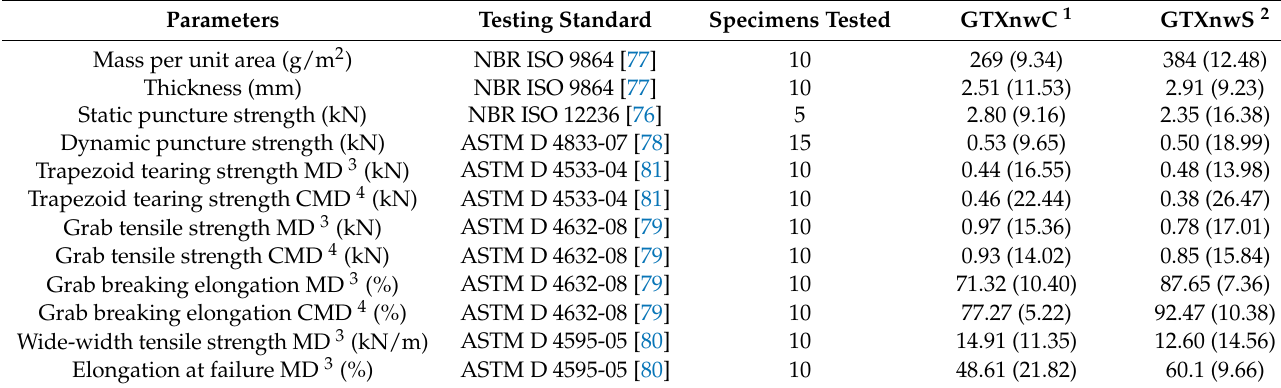
Table 1. Properties of the non-woven needle-punch geotextiles. [NOTE: The coefficients of variation (COV) are presented between parentheses in